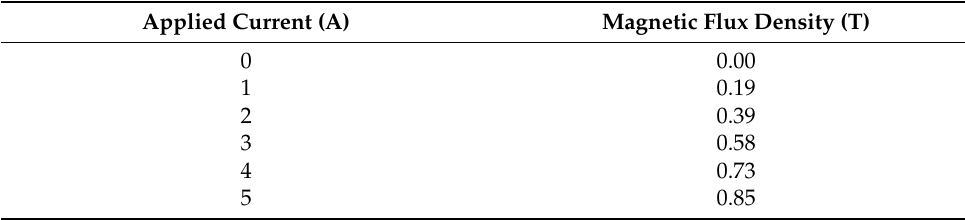
Table 2. The relationship between the applied current and magnetic flux density during the rheologi- cal